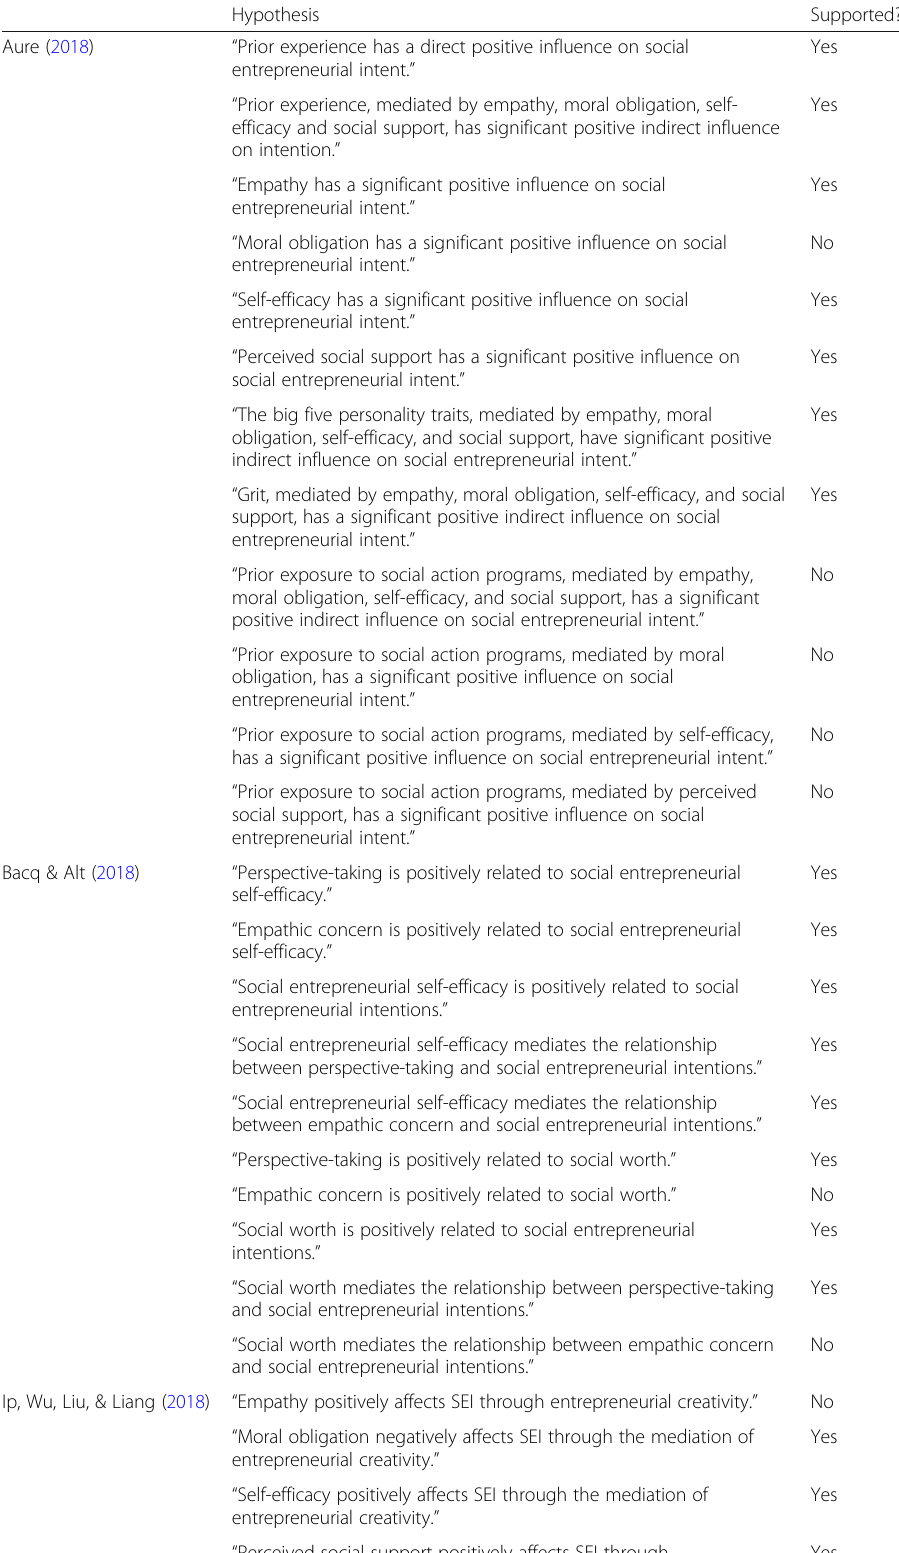
Table 2 Tabulated synthesis of results across different studies